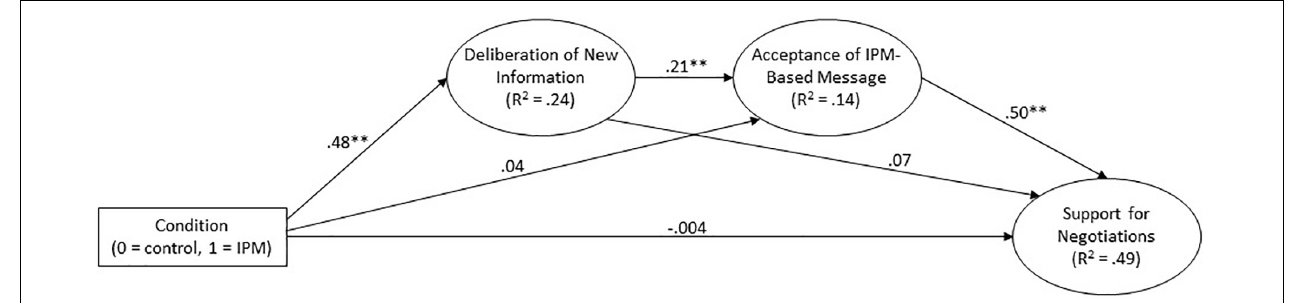
FIGURE 2 | Serial mediation structural model of the effect of the IPM-based intervention on support for negotiation in Study 2. Standardized coefficients are shown. Control variables (political orientation, gender, age), error terms and indicators are not shown. Full information is available in the Supplementary Materials . All coefficients correspond to the arrows beneath them. ∗∗ p <